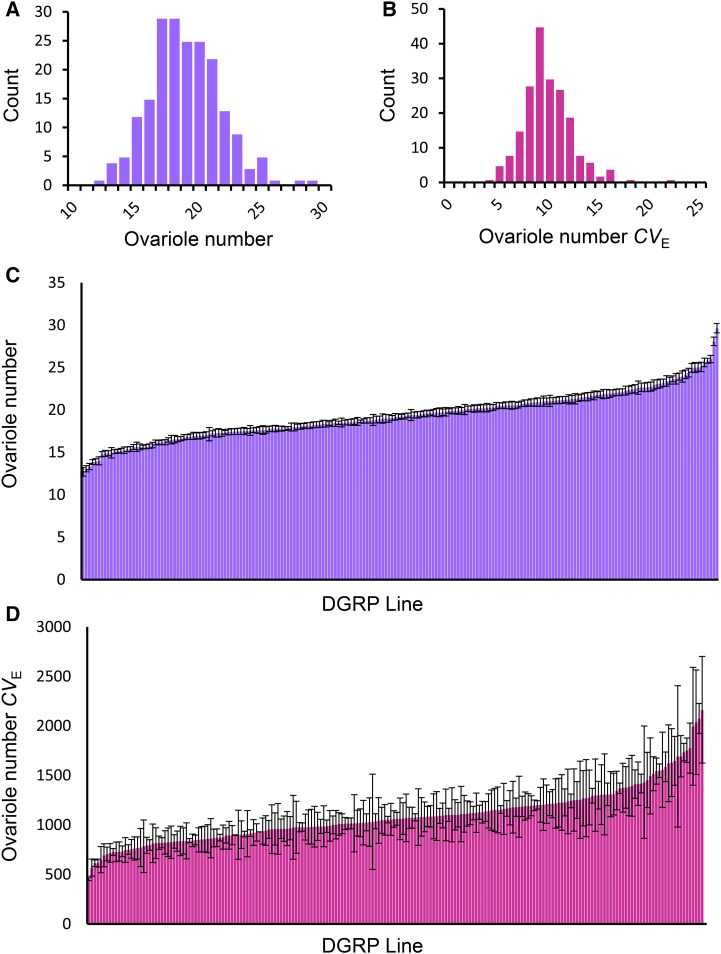
Variation in ovariole number in the DGRP. Histogram of (A) ovariole number and (B) ovariole number CVE line means. Mean and SE of (C) ovariole number and (D) ovariole number CVE.